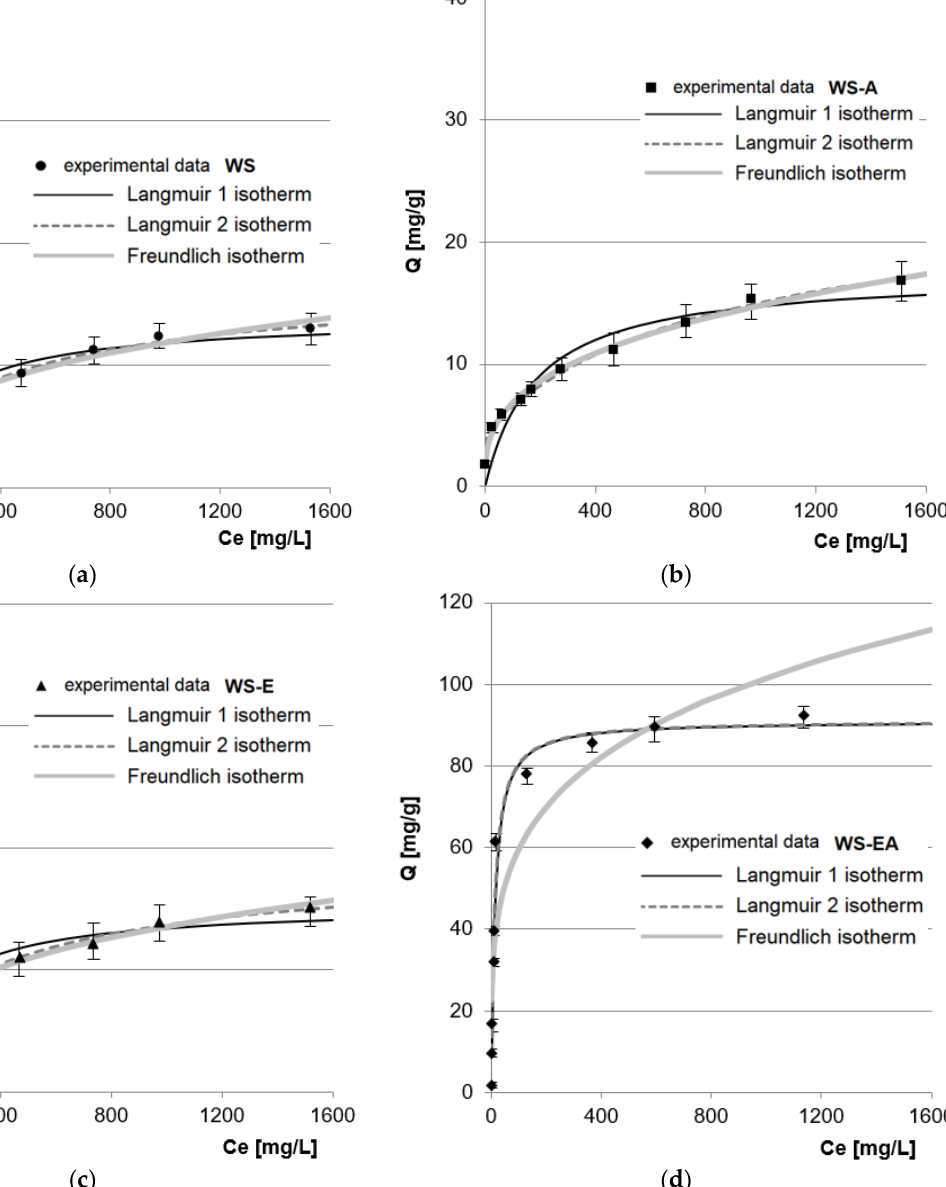
Figure 6. Isotherms of RB5 sorption onto: a ) WS; ( b ) WS-A; ( c ) WS-E; and ( d ) WS-EA, (average + range). Conc. of the solution: 10–1500 mg RB5/L, dose of the sorbent: 5 g/L, mixing speed: 150 r.p.m., sorption time: 240 min, temp. 22 °C. Table 5. Constants determined from Langmuir 1, Langmuir 2, and Freundlich models. Langmuir 1 Model Langmuir 2 Model Freundlich Sorbent